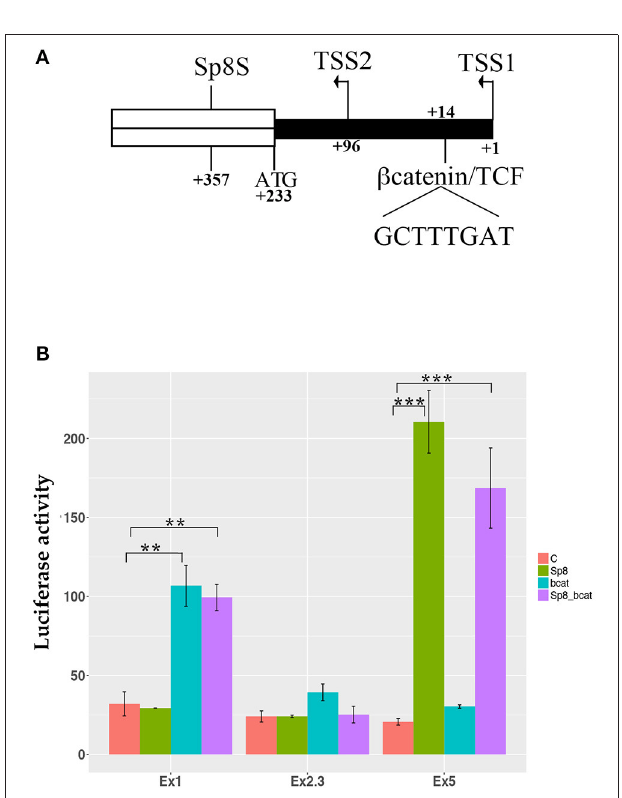
FIGURE 4 | β catenin and PAX6 transcriptional regulation of Ccnd1 regulative regions identified by SP8 ChipSeq. (A) represents the schema of the 5 ′ portion of the exon 1 fragment. The transcriptional start sites, TSS1 and TSS2, the first codon ATG, and the conserved β catenin binding site (Klein and Assoian, 2008), and the SP8 summit (SP8S) positions are indicated. The 5 ′ UTR region is depicted in black; the ORF of exon 1 is indicated in white. Panel (B) shows the results of the luciferase assay obtained from one representative experiment. P19 cells were transfected with the Ccnd1 exon fragments identified by SP8 ChipSeq alone or in combination with β catenin, SP8, or β catenin together with SP8. Statistical significance, ANOVA: ** p < 0.01, *** p <